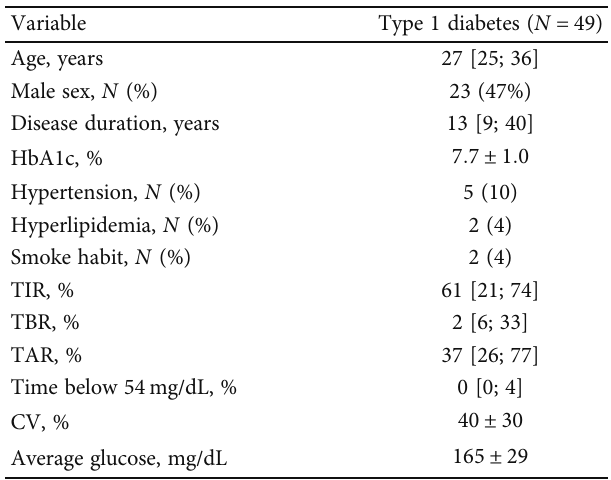
Table 1: Clinical characteristics and CGM-derived glucose metrics of the enrolled patients.